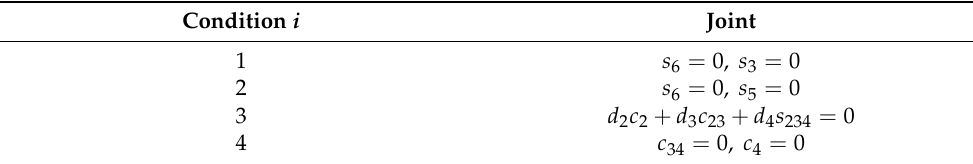
Table 2. Joint singularity conditions.